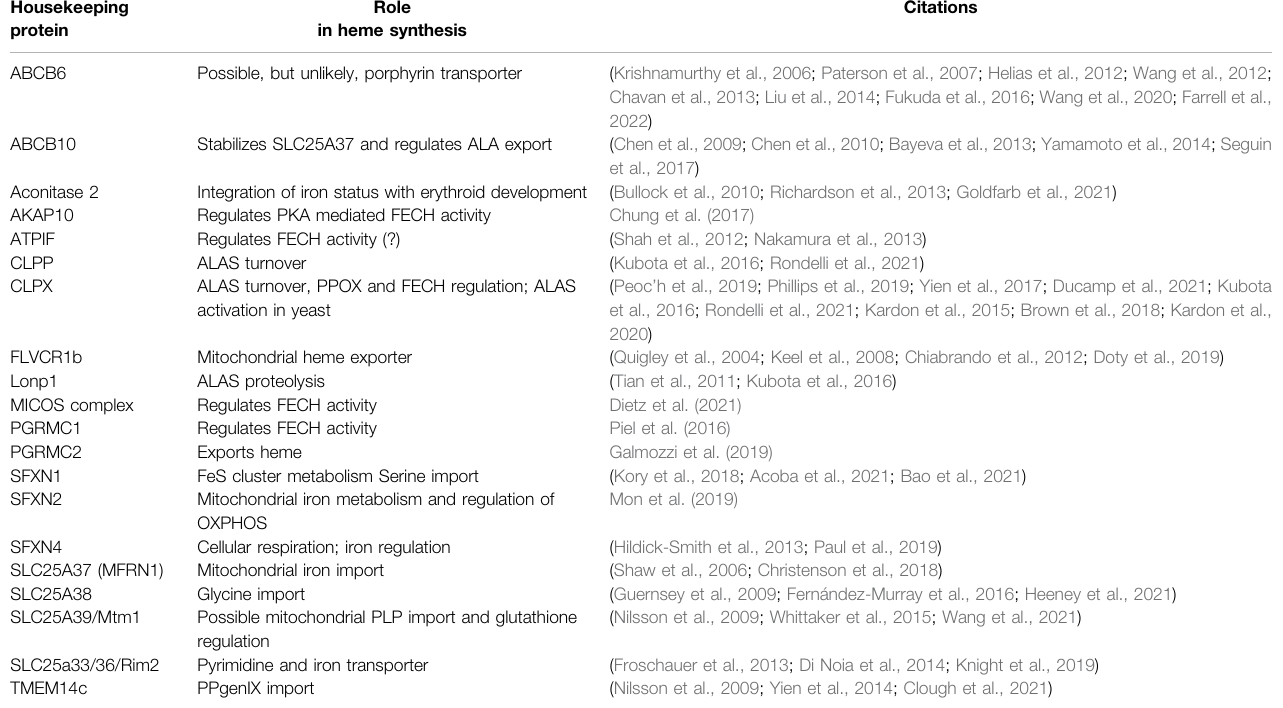
TABLE 1 | Mitochondrial housekeeping proteins with known effects on heme synthesis. Housekeeping